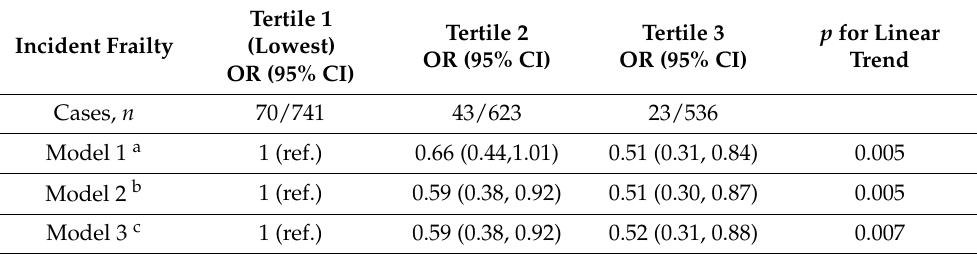
Table 3. Risk of incident frailty according to tertiles of adherence to the Healthy Beverage Score in the Seniors-ENRICA-1 cohort ( n = 1900).